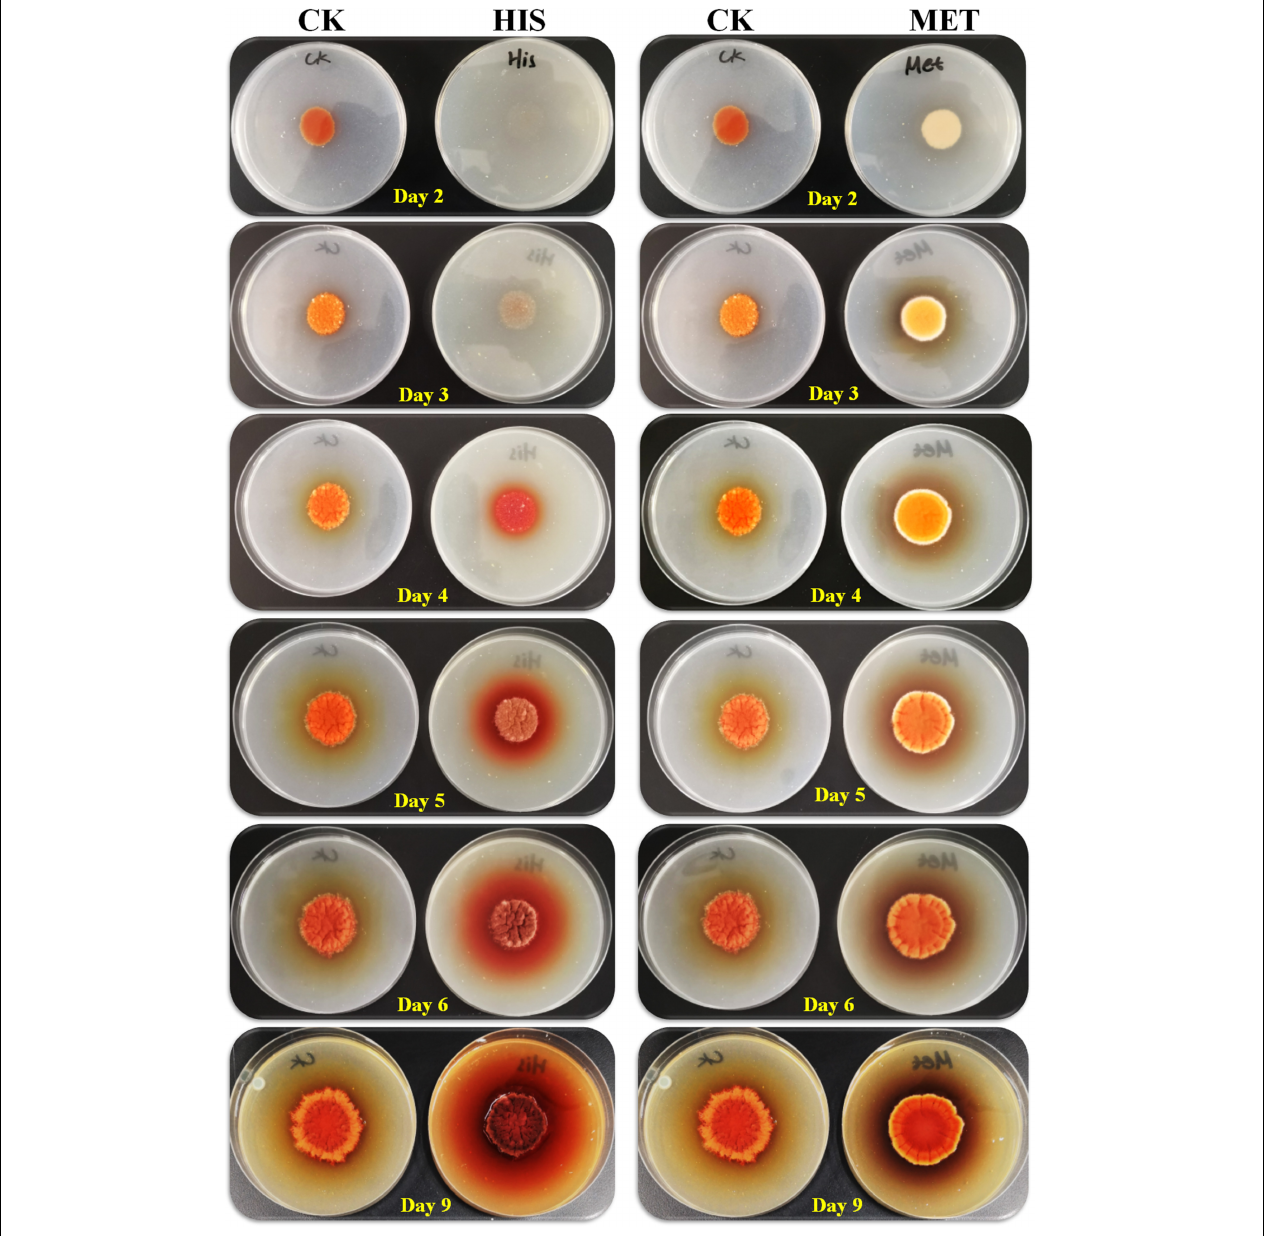
FIGURE 5 | Growth of Monascus purpureus RP2 in fermentation plates with the addition of HIS and MET. CK, growth of M. purpureus RP2 in the fermentation plate without the addition of amino acid; HIS, growth of M. purpureus RP2 in the fermentation plate with the addition of HIS; MET, growth of M. purpureus RP2 in the fermentation plate with the addition of